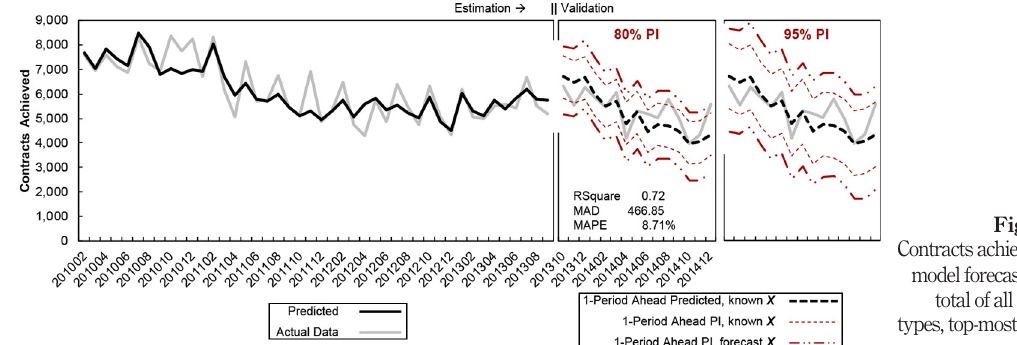
Table VIII. Final SA models for